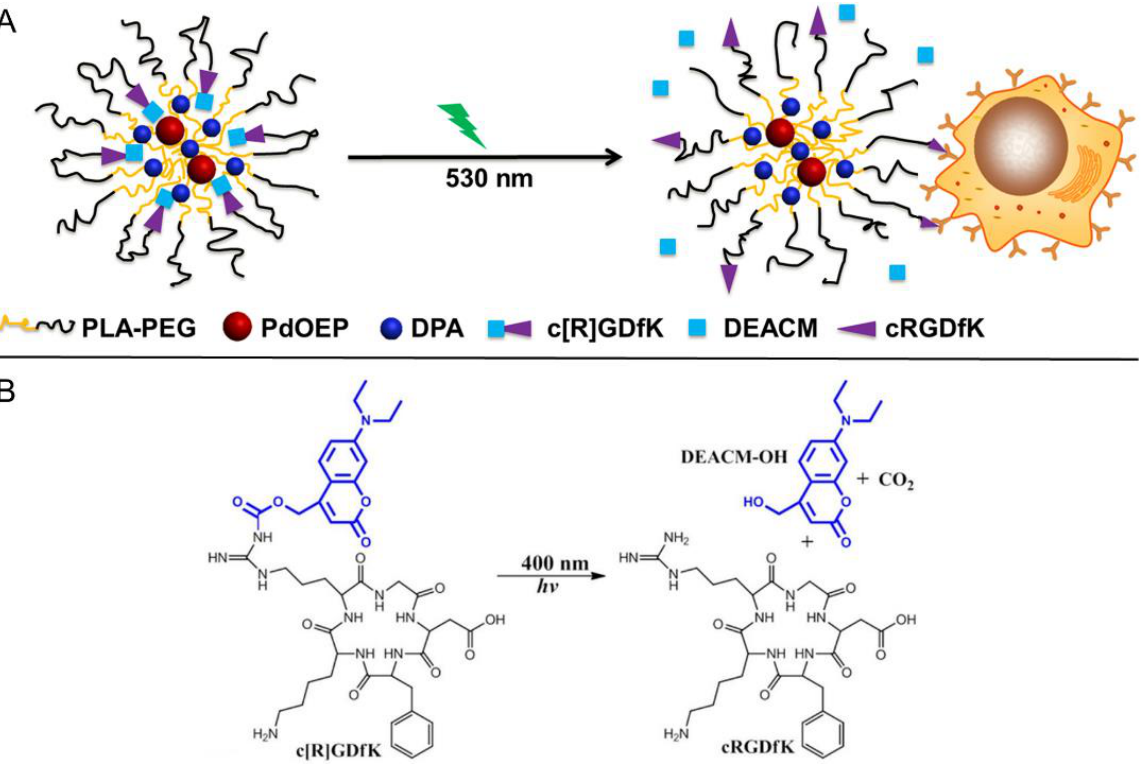
Figure 14. ( A ) Schematic illustration of the photocleavage of the polymeric micellar nanoparticles via TTA-UC and FRET. ( B ) Photocleavage reaction of c[R]GDfK (excitation at 400 nm). Reprinted with permission from ref. [147]. Copyright 2015 American Chemical Society.